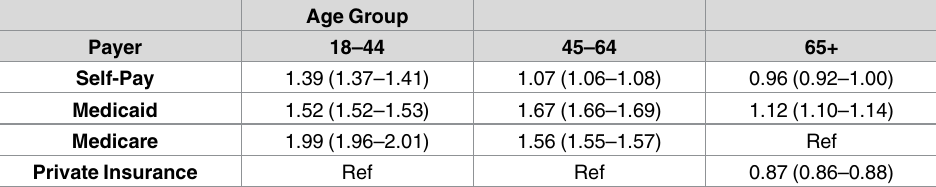
Table 2. Adjusted odds of 30-day readmission by age category and payer group a